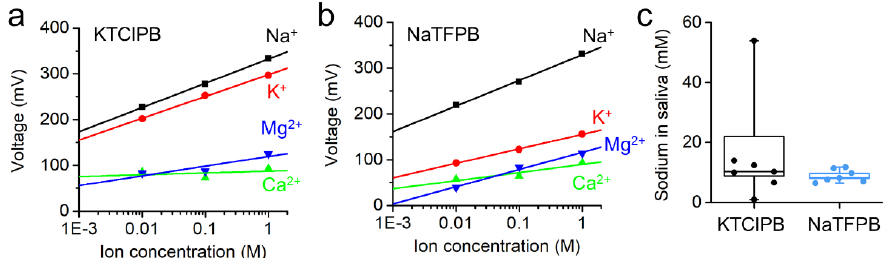
Figure 4. Performance comparison of film ISEs with different anionic sites. Sensitivity and selectivity results based on ( a ) potassium anionic site (KTClPB) and ( b ) sodium anionic site (NaTFPB). ( c ) Comparison of detected sodium levels in saliva measured seven times from both ISEs. Table 1. Sensitivity and selectivity data of film ISEs based on different anionic sites.